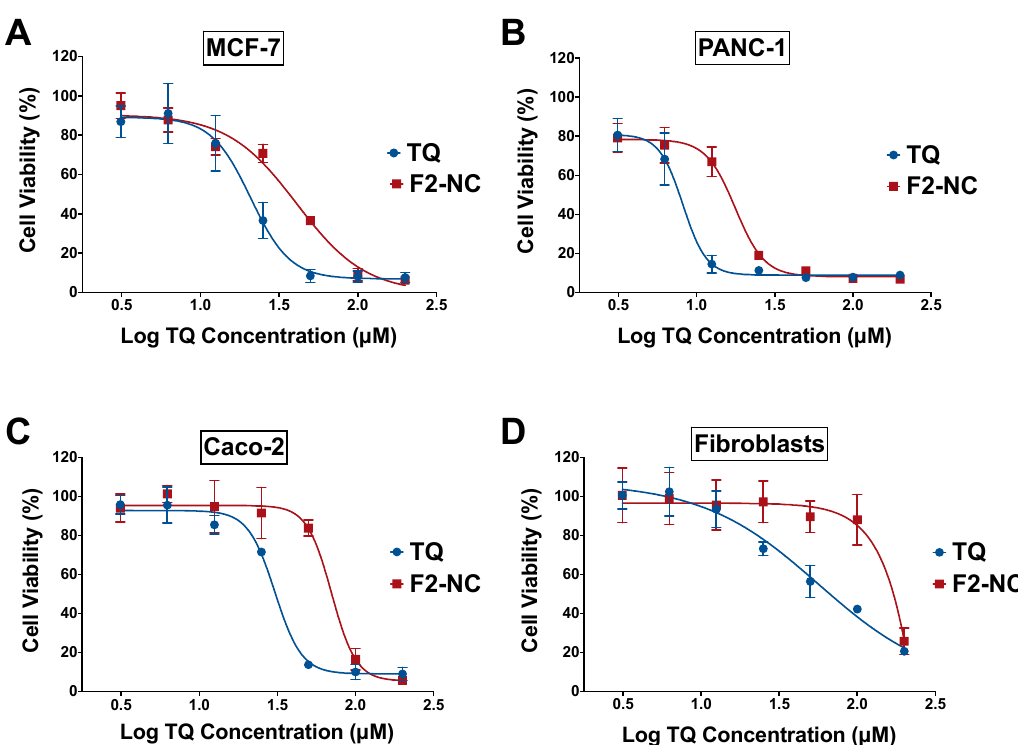
Figure 6. Antiproliferative activity of free TQ and the optimized TQ NP formulation F2-NC in ( A ) MCF-7, ( B ) PANC-1, and ( C ) Caco-2 human cancer cell lines, as well as ( D ) human dermal fibroblasts serving as a model normal cell line. Cells were incubated with various concentrations of TQ in its free or NP form in complete media for 72 h. Cell viability was measured via a sulforhodamine B (SRB) assay and expressed relative to untreated controls. TQ and F2-NC exhibited dose-dependent cytotoxicity with micromolar potencies across all cancer cell lines. Although free TQ was more potent than F2-NC, the latter was significantly less toxic to fibroblasts and was associated with a greater selectivity index. Table 2. Summary of IC 50 values and selectivity indices (SI) for TQ and F2-NC. Cell Line